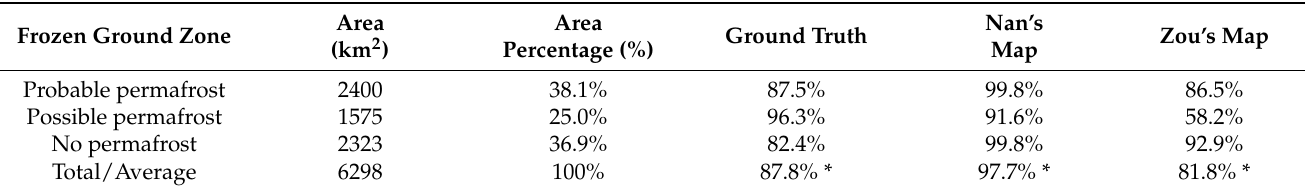
Table 2. The areas and proportions of different permafrost zones based on the mapping results, as well as their consistency with existing maps and ground truth from survey field